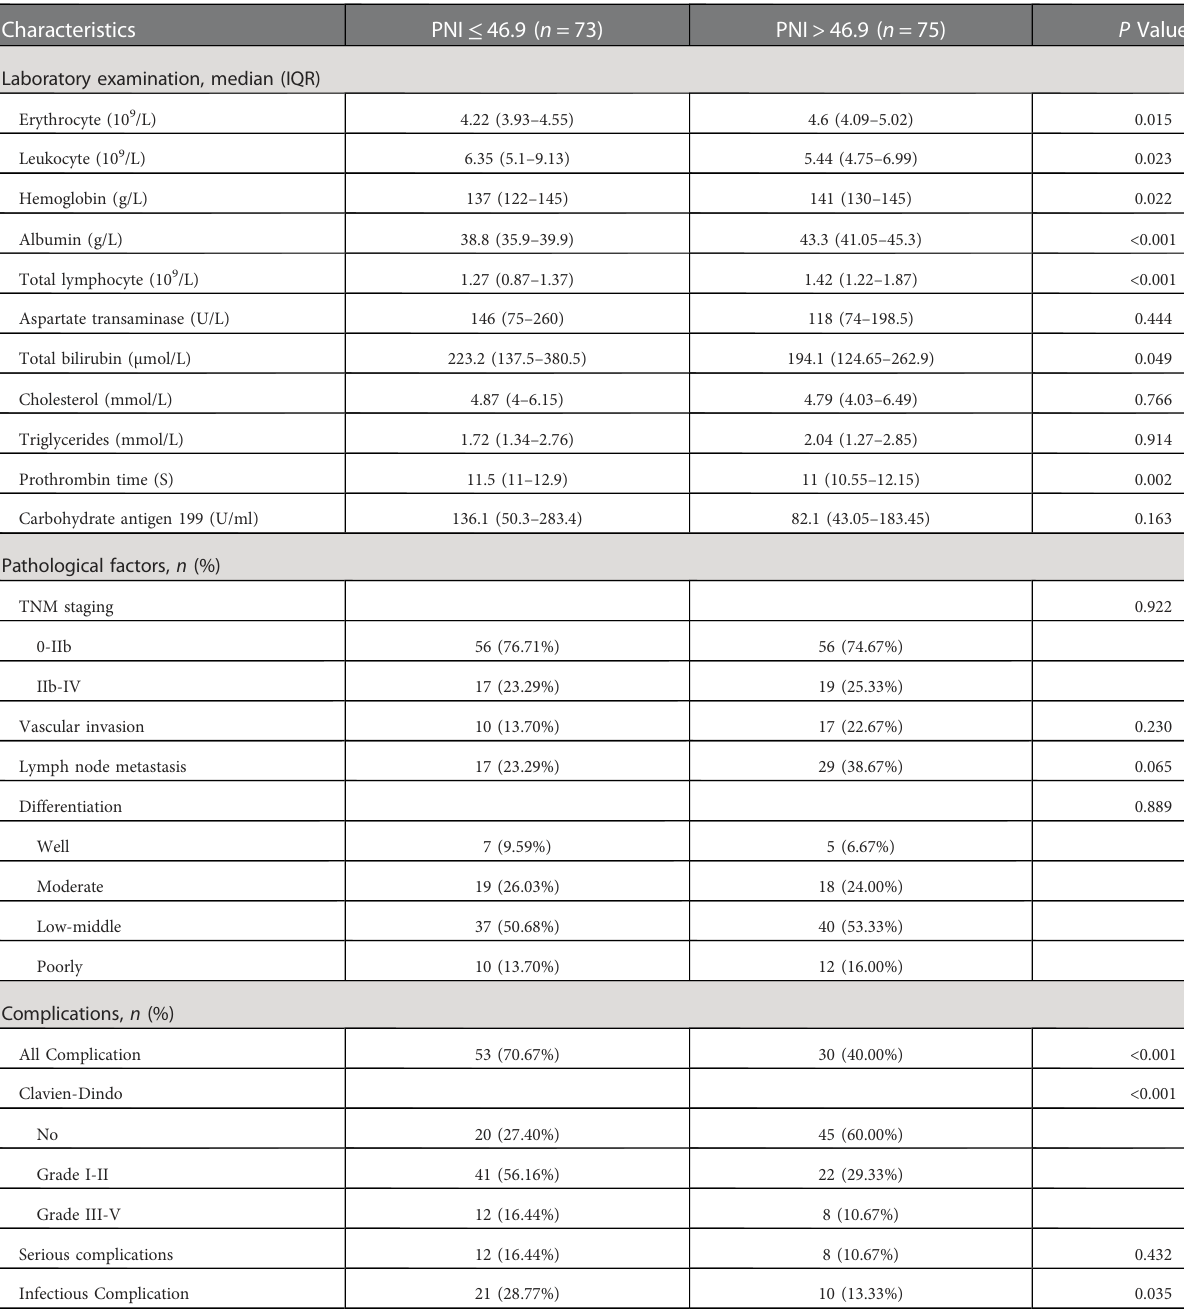
TABLE 3 Clinicopathological characteristics of the low PNI group and the high PNI group.